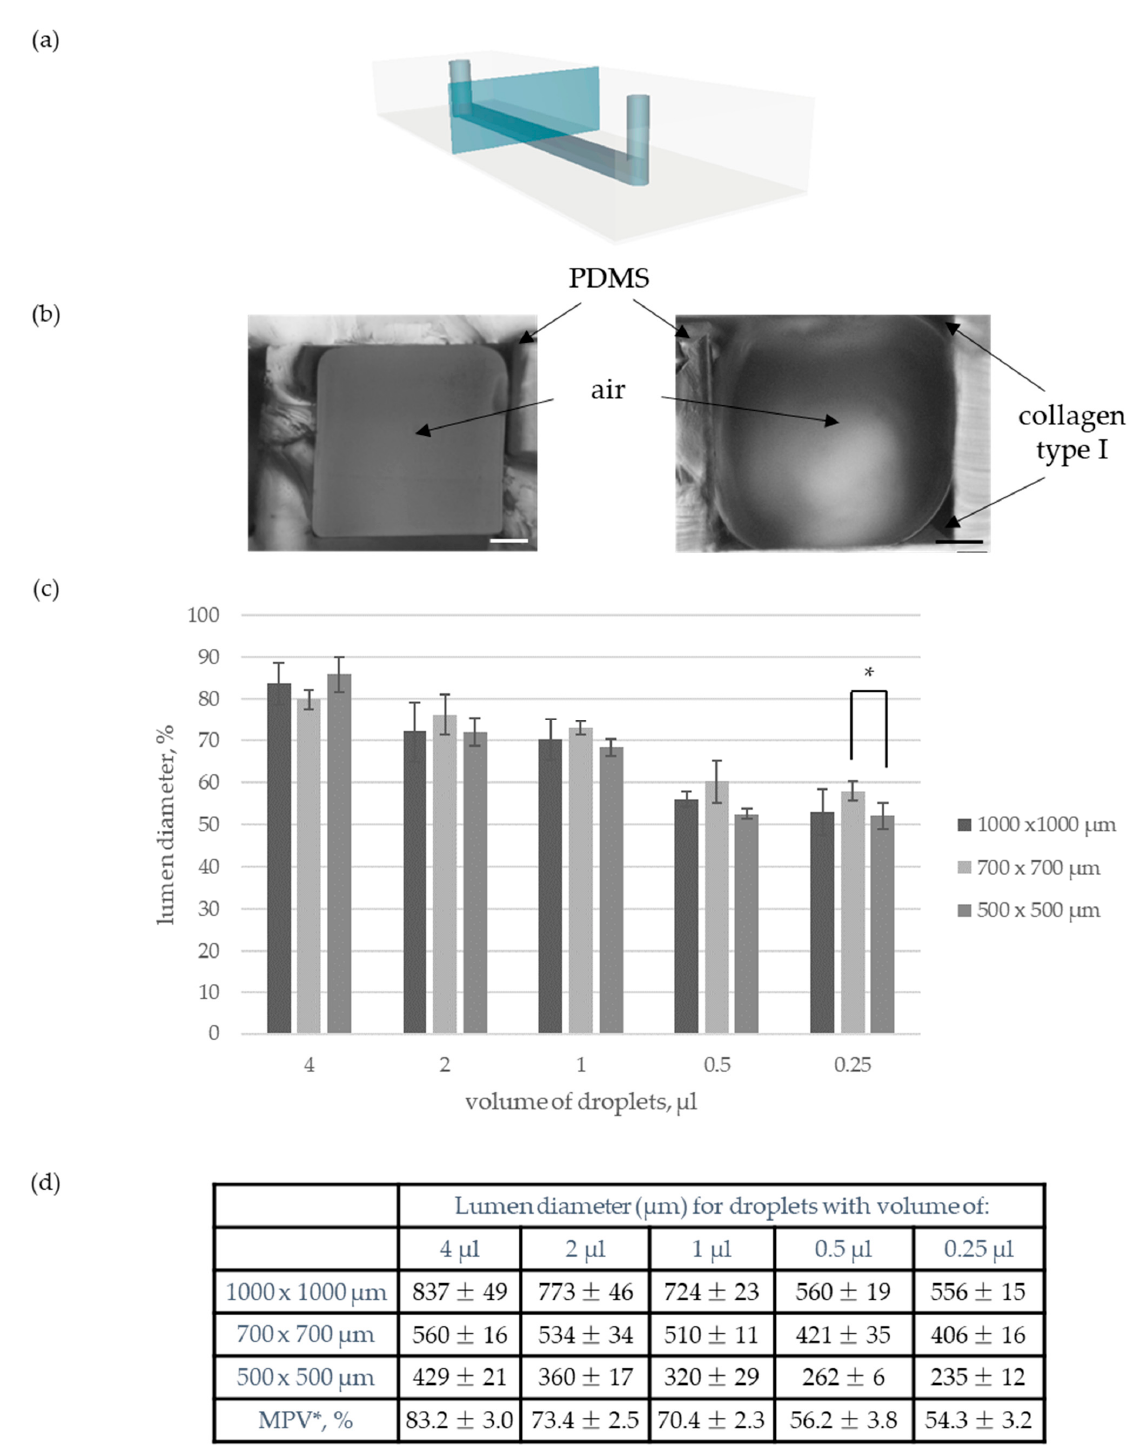
Figure 2. ( a ) Schematic view of single microchannel with marked section plane used for following photos. ( b ) Microchannel’s cross-section before and after modification by VFP. Scale bar: 200 µm. ( b ) Influence of droplet’s volume on lumen diameter. ( c ) Mean values of lumen diameter. * Mean percentage value of rectangular microchannel’s width covered by lumen